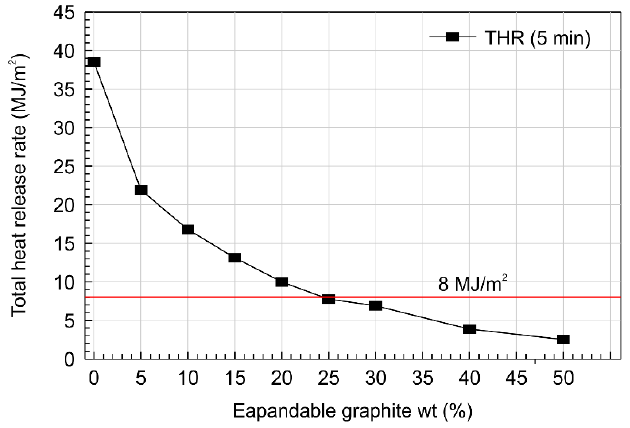
Figure 11. Variations in total heat released (THR) with expandable graphite content.